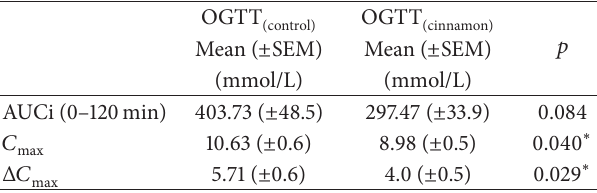
Table4:Bloodglucoselevelareaunderthecurve(AUC),maximum glucose concentration ( 𝐶 max ), and variation of maximum glucose concentration ( Δ𝐶 max ) in nondiabetic subjects at OGTT . Data are mean ± SEM ( 𝑛 = 15 ). OGTT (cinnamon)